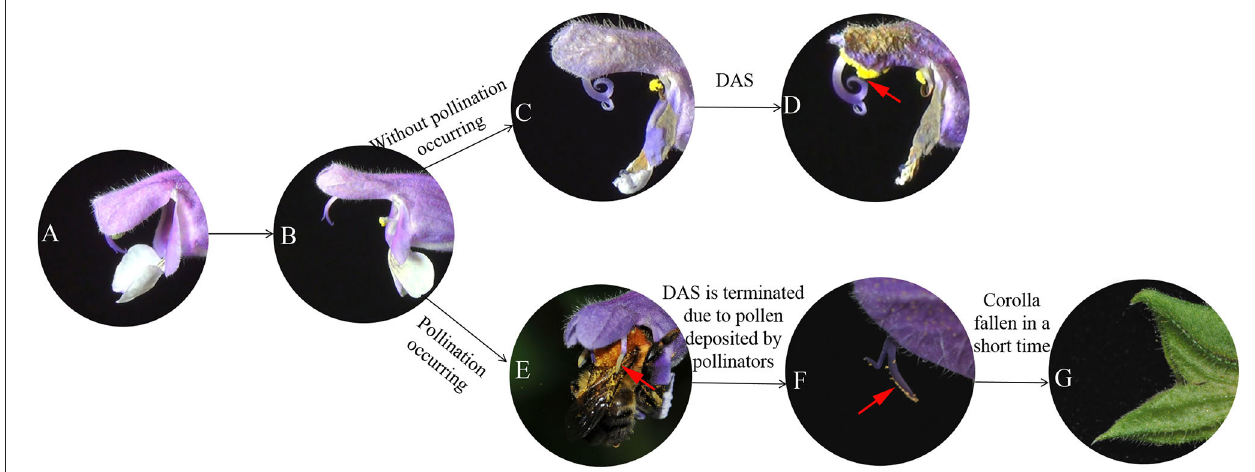
FIGURE 2 | (A–D) Different stages of flower development during the process of DAS, and (E,F) when DAS is terminated after bumblebee pollination. (A) Flower opens when upper and lower lips of corolla separate (0h); (B) fully opened flower shows stigma with receptive surface oriented outward and unfurled; (C) style begins to recurve, orienting receptive surface of stigma toward upper thecae; (D) receptive surface of stigma makes contact with upper thecae resulting in selfing (arrow shows stigma receptive surface touching upper thecae); (E) flower pollinated by a bumblebee; (F) style does not recurve toward upper thecae, arrow indicates stigmatic receptive surface has pollen deposited on it by pollinator; (G) corolla has fallen away (dropped) from flower a short time after pollination.